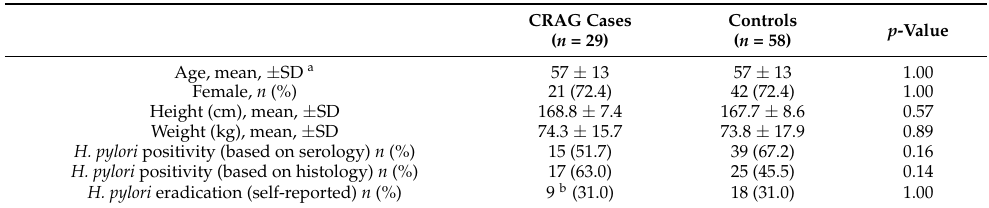
Table 1. Description of sociodemographic variables and H. pylori status in corpus-restricted atrophic gastritis (CRAG) patients and controls.